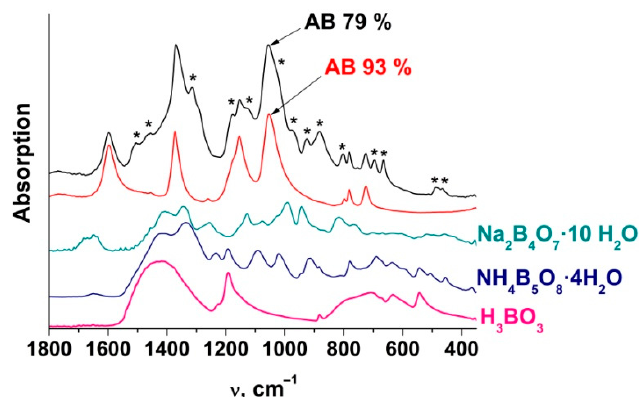
Figure 4. ATR FTIR spectra in the vibration region of borate anions for the sample of NH 3 BH 3 with the 93 and 79% purity, and of sodium and ammonium borates containing three- and four-coordinated boron, and boric acid. The absorption bands not belonging to NH 3 BH 3 are marked by *.